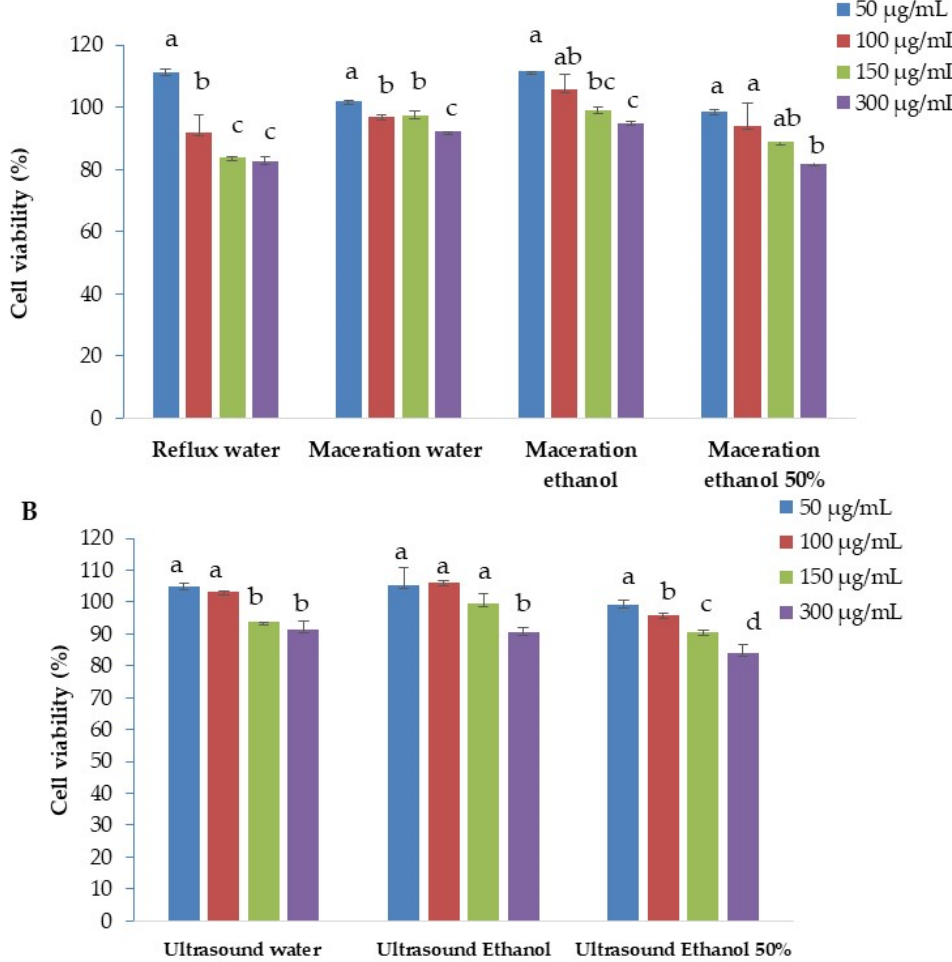
Figure 1. Cell viability (%) evaluation using resazurin assay for Arbutus unedo extracts obtained by reflux and maceration ( A ) and ultrasound ( B ) extraction on RAW 264.7 cells. Cells were incubated, for 24 h, with 50–300 μ g/mL extract. The percent cell viability was determined by comparison to the untreated control. Data were displayed as mean ± SD calculated from triplicate results. For each extraction method, different letters between extract concentrations mean significant differences using Duncan’s test at a 0.05 probability level.